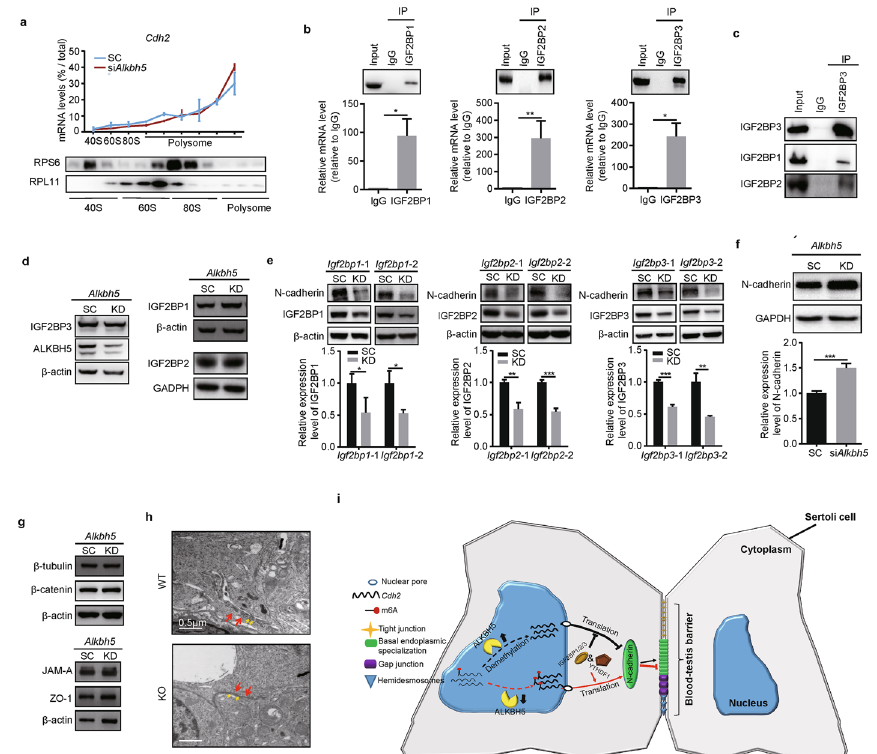
Fig. 5 ALKBH5 regulates Cdh2 mRNA translation via the IGF2BP1/2/3 complex and basal endoplasmic specialization via N‑cadherin. a Polysome profiling analysis for detecting the translation efficiency of Cdh2 mRNA in TM4 cells with and without Alkbh5 knockdown. Western blot analysis was performed by using RPS6 and RPL11 to detect the efficiency of polysome fractionation. b RIP–qPCR to detect the interaction between IGF2BP1, IGF2BP2, or IGF2BP3 proteins and Cdh2 mRNA. c Coimmunoprecipitation to detect the interaction between IGF2BP1, IGF2BP2, and IGF2BP3 proteins. d Western blot analysis to detect the expression of IGF2BP1, IGF2BP2, and IGF2BP3 after silencing Alkbh5 in TM4 cells. β‑Actin and GAPDH were used as internal controls. e Western blot analysis to detect the expression of N‑cadherin after knocking down Igf2bp1 , Igf2bp2 , or Igf2bp3 . β‑Actin was used as an internal control. f Western blot analysis showing the expression of N‑cadherin before and after knocking down Alkbh5 . GAPDH was used as an internal control. g Some key BTB‑related molecules detected by western blot analysis. β‑Actin was used as an internal control. h Images showing the ultrastructure of basal endoplasmic specialization (marked by red arrow) in the testis of WT or Alkbh5 ‑KO mice as observed under transmission electron microscopy. Yellow arrow indicates actin bundles. i Schematic diagram elucidating the mechanism of ALKBH5 in regulating the integrity of the blood–testis barrier. Under physiological conditions with normal ALKBH5 expression, Cdh2 mRNA is maintained at a relatively low m 6 A level and is kept away from the IGF2BP1/2/3 complex and YTHDF1‑mediated translation of Cdh2 . Thus, N‑cadherin is expressed at a reasonable level to maintain the stability of basal endoplasmic specialization and integrity of the blood–testis barrier. However, insufficient ALKBH5 protein expression leads to hypermethylation of Cdh2 mRNA and further facilitates its translation under the action of the IGF2BP1/2/3 complex and YTHDF1. Consequently, overexpression of N‑cadherin disrupts the stability of basal endoplasmic specialization and integrity of the blood–testis barrier. * P < 0.05, ** P < 0.01, *** P <